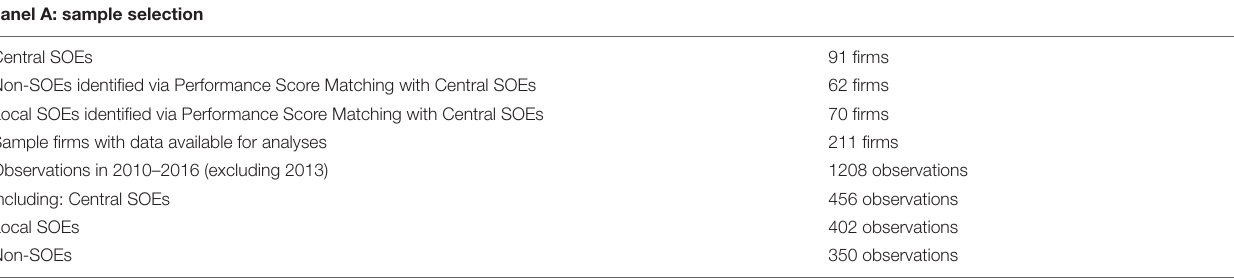
TABLE 1 | Sample selection and descriptive